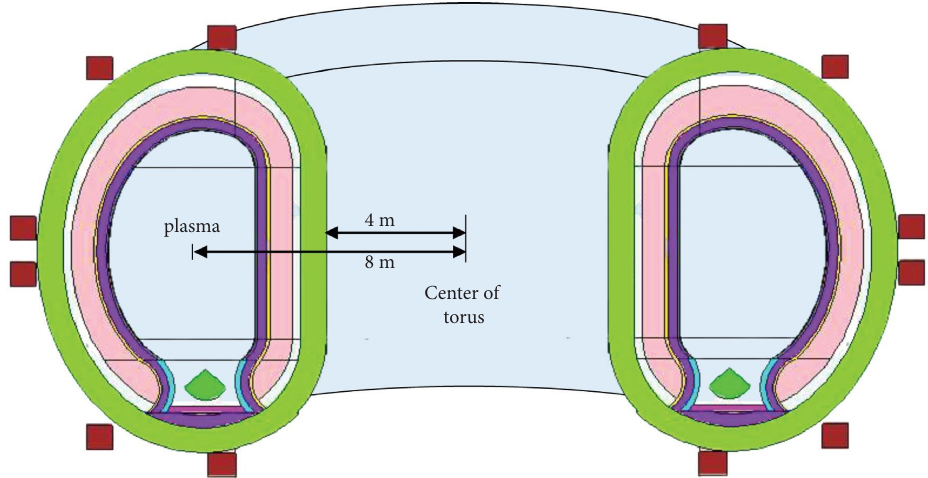
Figure 1: Blanket module with specifcation layer in the HCLL TBM reactor.